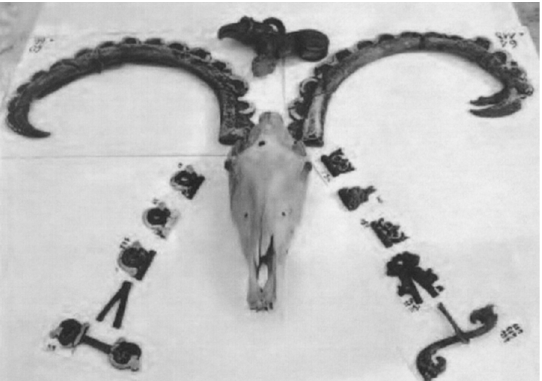
Figure 9. Horse mask. Wood, leather, gold foil. Berel, Kurgan 11, Kazakhstan (Adapted from Francfort 2008, p. 35).